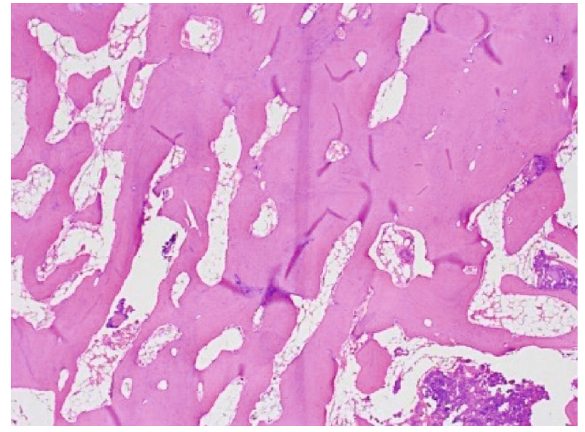
Figure 4: Histology of the fracture site. An increase in the empty lacunae is observed in the thickened bony trabeculae under low magni fi cation of the bone sample around the fracture site (100x).